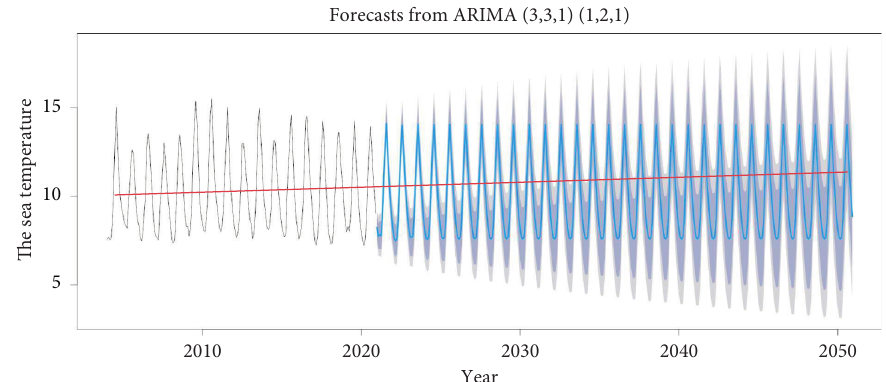
Figure 12: Time series forecast of monthly average sea temperature in region 13.